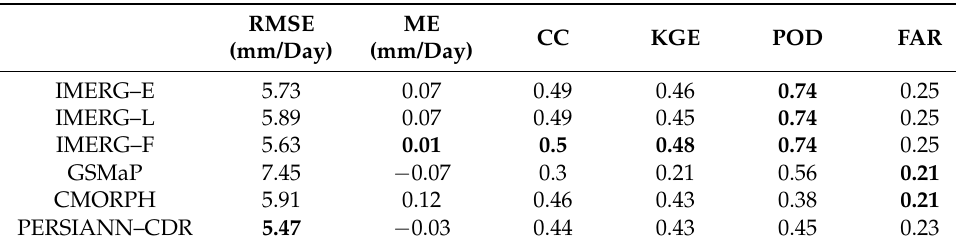
Table 3. Daily precipitation statistics of the six satellite precipitation products over mainland China from 2001 to 2015